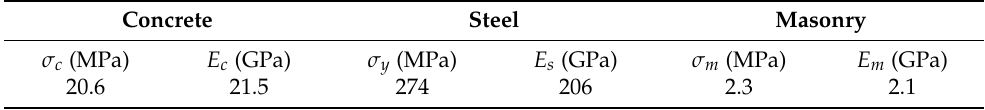
Table 1. Mechanical properties of the materials.